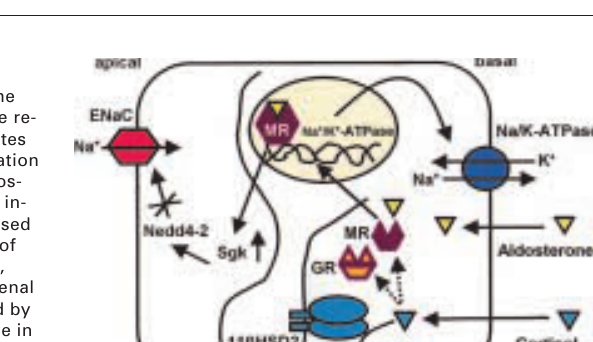
Figure 1 Sodium absorption by the renal tubular system. Upon filtra- tion in the glomeru- lus, the epithelial cells along the renal tubular system reab- sorb water and elec- trolytes. The amounts of sodium reabsorbed in each segment and the main transport pro- teins involved are indicated. The fine- tuning of sodium balance occurs in the cortical collecting duct by determining the amount of sodium excretion.